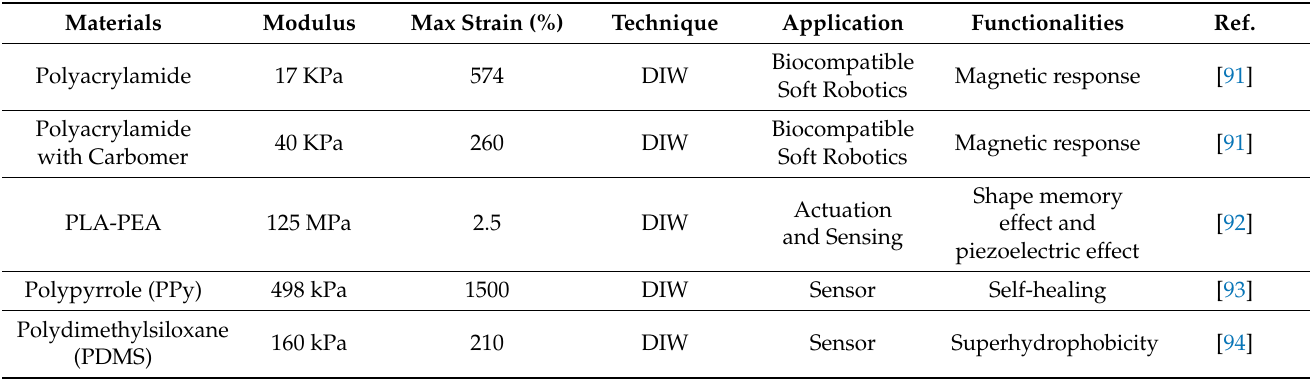
Table 6. Different multifunctional soft materials recently manufactured using AM techniques and their applications. Materials Modulus Max Strain (%) Technique Application